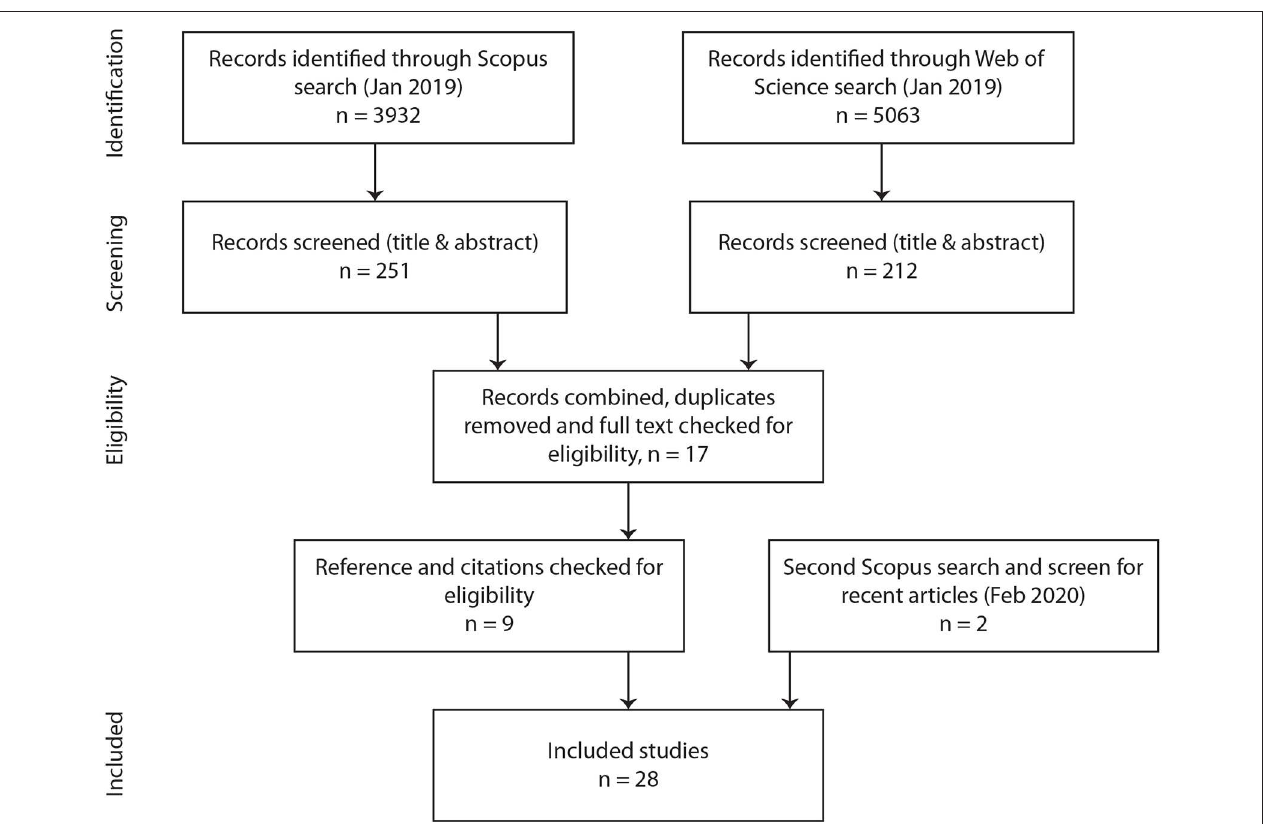
FIGURE 2 | Identification and screening flow